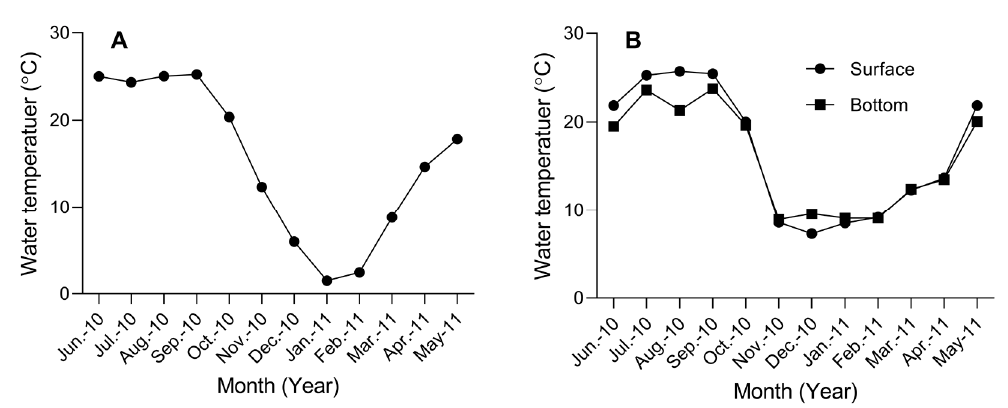
Figure 2. Seasonal changes in the surface and bottom water temperatures at freshwater ( A ) and estuary ( B ) regions at the lower Nakdong River.